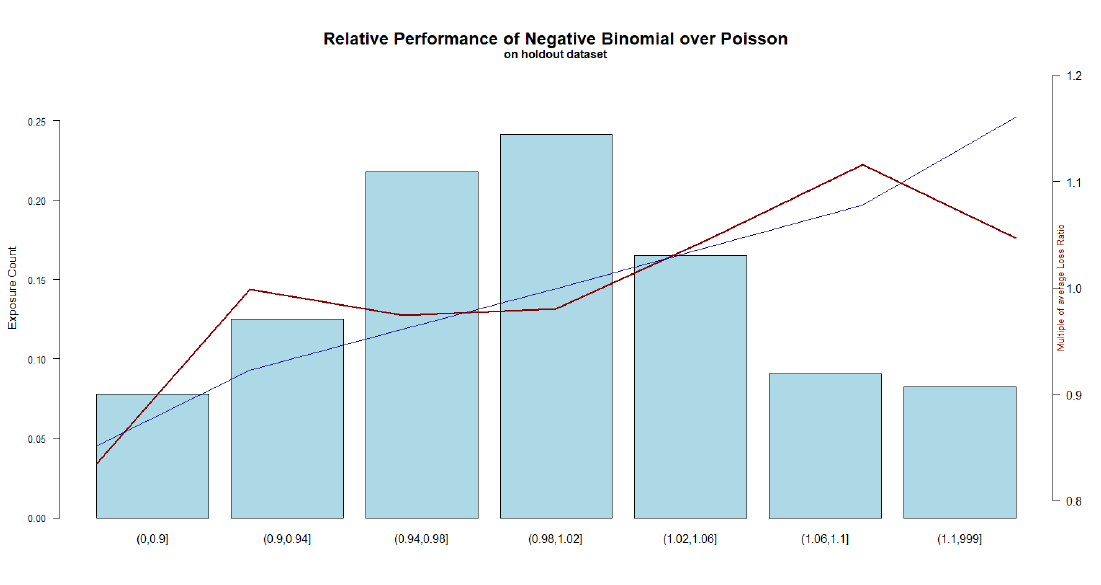
Figure 4. Double lift plot for delta boosting (DB) implementation of negative binomial over Poisson. From Figure 4, we witness a significantly positive relationship between the blue line (indicated rate change) and the red line (loss ratio), with a correlation of 0.82, indicating the negative binomial distribution is able to pick up the residuals from the